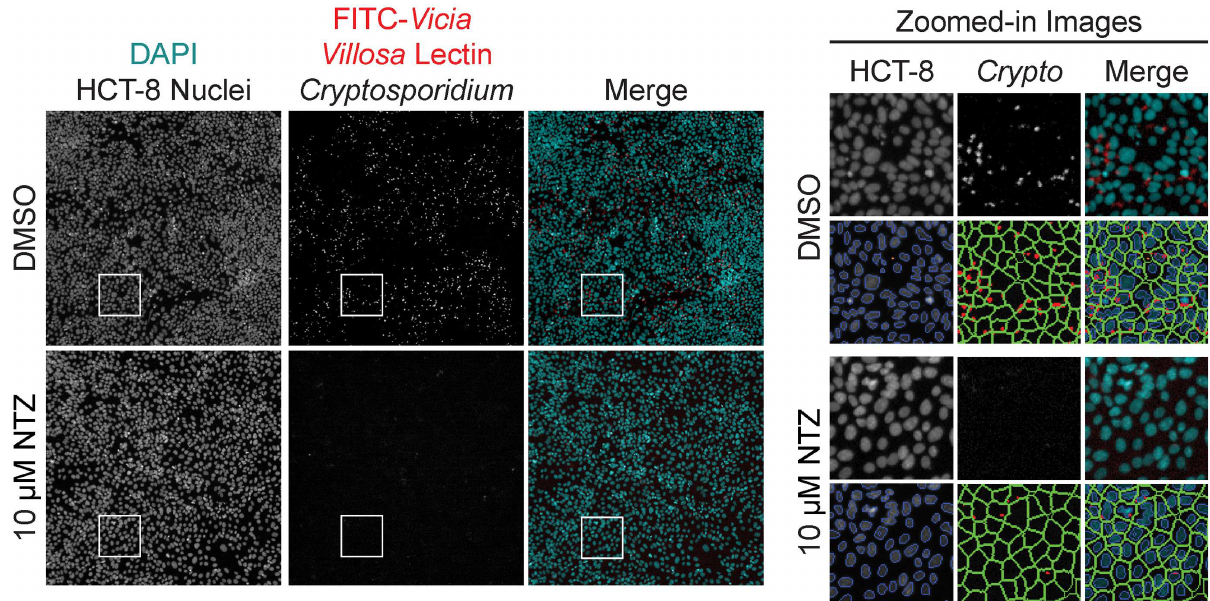
Fig 1. Screening images and software analysis. Representative images and software analysisfrom 1536-wellHigh Content Imaging on CellomicsCellInsightCX5. (Left) Images of two wells either mock-treated with dimethyl sulfoxide(DMSO) or 10 μ M nitazoxanide (NTZ). A merged image of the two fluorescent channelsare artificially colored to show contrast: DAPI in cyan and FITC in red. Well area for each full- sized image is 802,511.39 μ m 2 . (Right) Zoomed-in images from the inset white squares in the left panel (area is 24,318.53 μ m 2 ) are shown. The image overlays are appliedby the imagingsoftware to assess the assay metrics: HCT-8 cell count and Cryptosporidium spot count. First, the host cell nucleiare identified and countedbased on DAPI signal; cell debrisand other particles are rejectedbased on a size filter (orange). Next, a regionof interest, or “cell area” is drawn aroundeach host cell nuclei to encompasswhere Cryptosporidium parasites may be located. Finally, the software identifies and counts “spots” within the “cell area” basedon signal from the FITC-conjugated Vicia villosa lectin